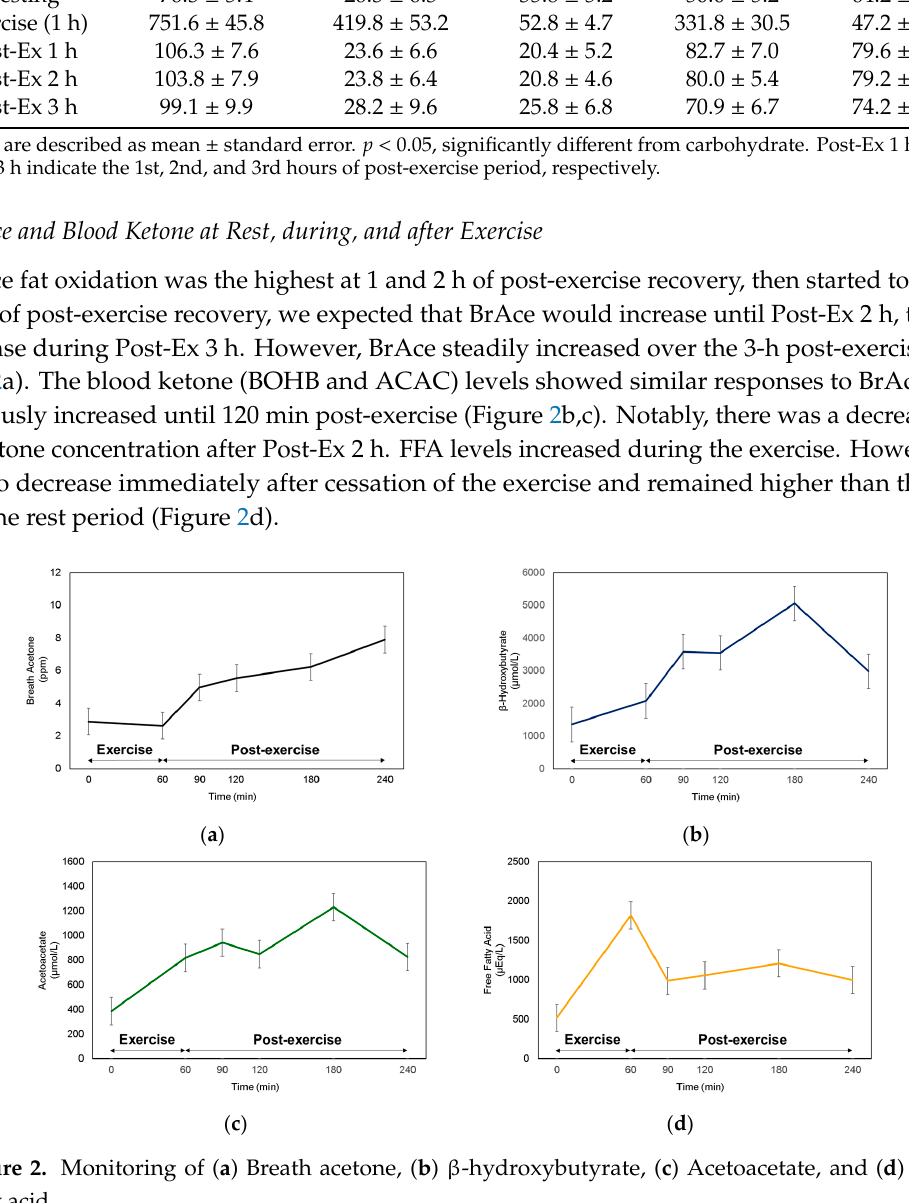
Table 2. Energy expenditure and substrate oxidation at rest, during, and after exercise.